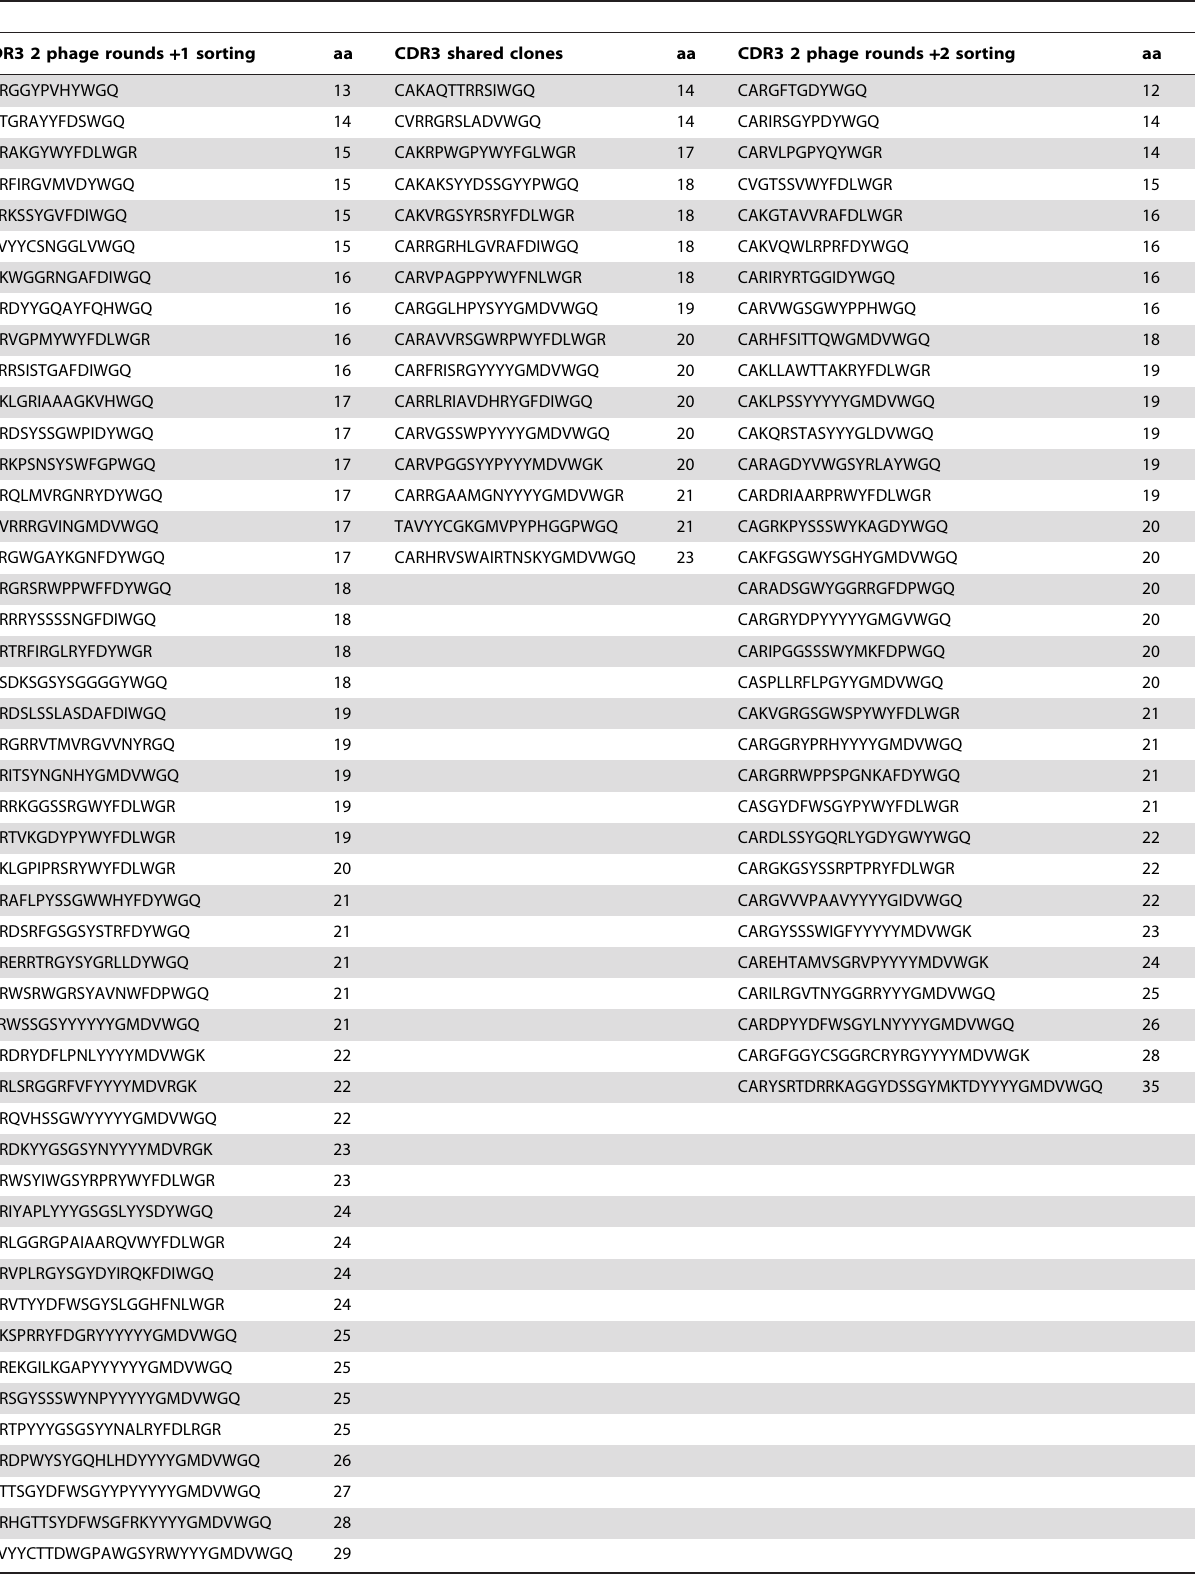
Table 1. CDR3 protein sequences of the different scFvs obtain after one or two round of yeast display